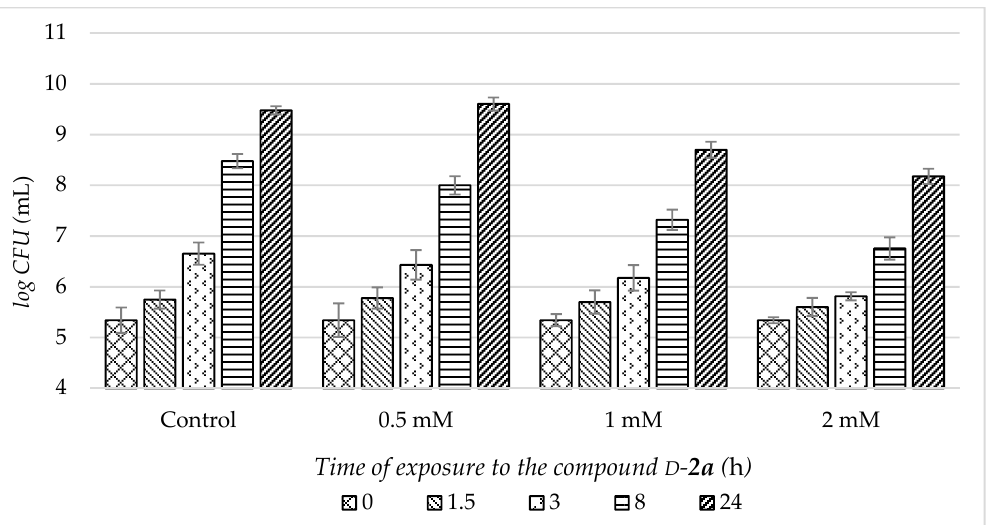
Figure 11. Bacterial density expressed as log CFU/mL of P. aeruginosa at baseline and after 1.5 h, 3 h, 8 h, and 24 h of incubation without (control) and in the presence of 0.5 mM, 1 mM, and 2 mM of compound D - 2a . Each column and bar represent the mean and standard deviation, respectively ( n = 2). CFU, colony-forming unit.